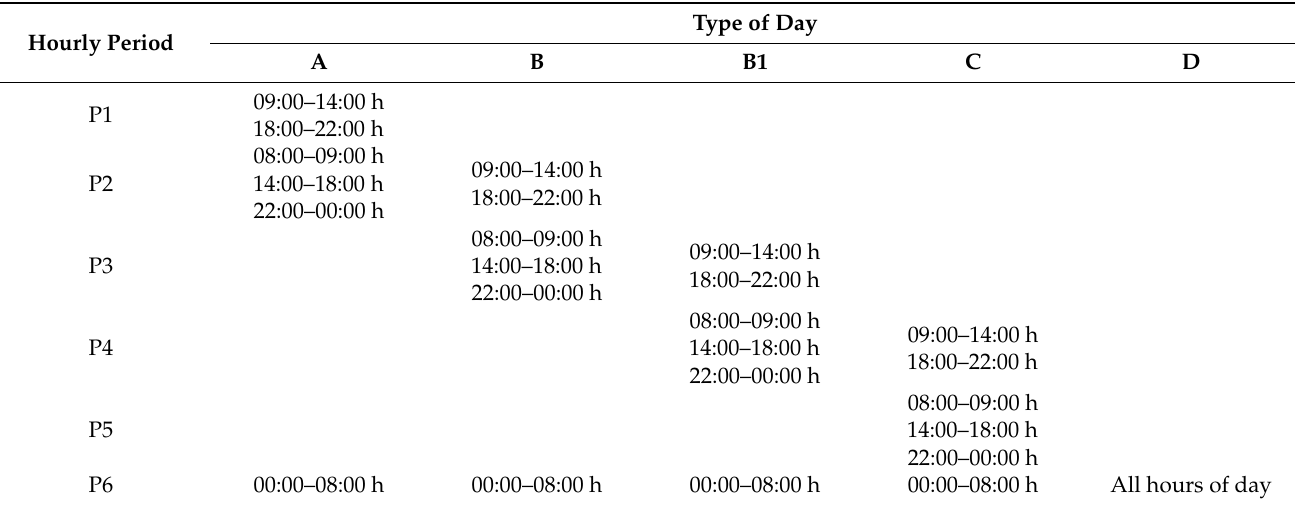
Table 3. Hourly billing periods depending on the type of